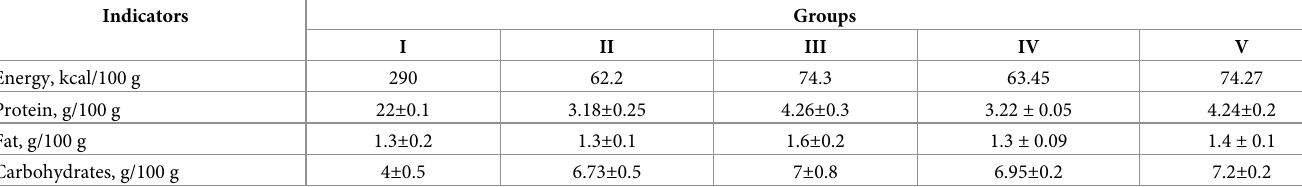
Table 2. The energy, the total number of proteins, fat, and carbohydrates of the diets per 100 g.